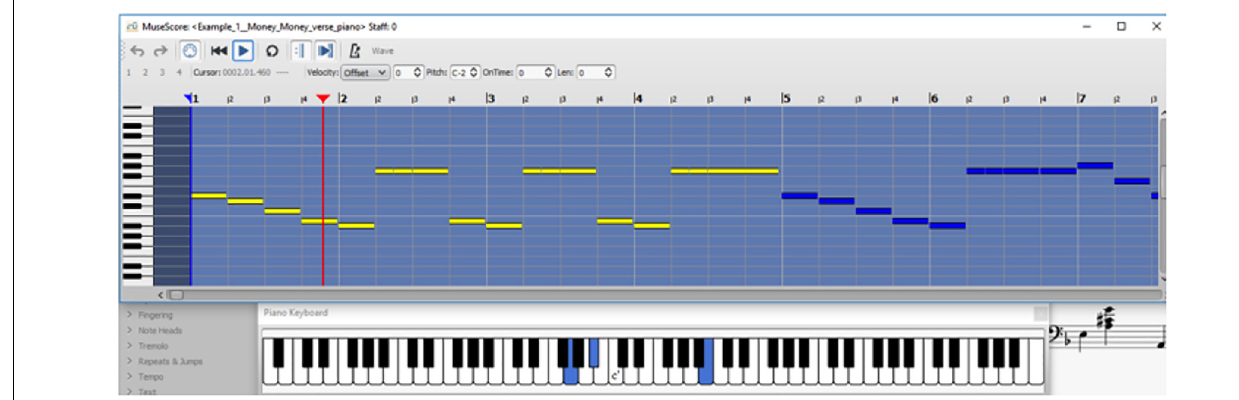
FIGURE 8 | Piano-roll view of the verse theme.